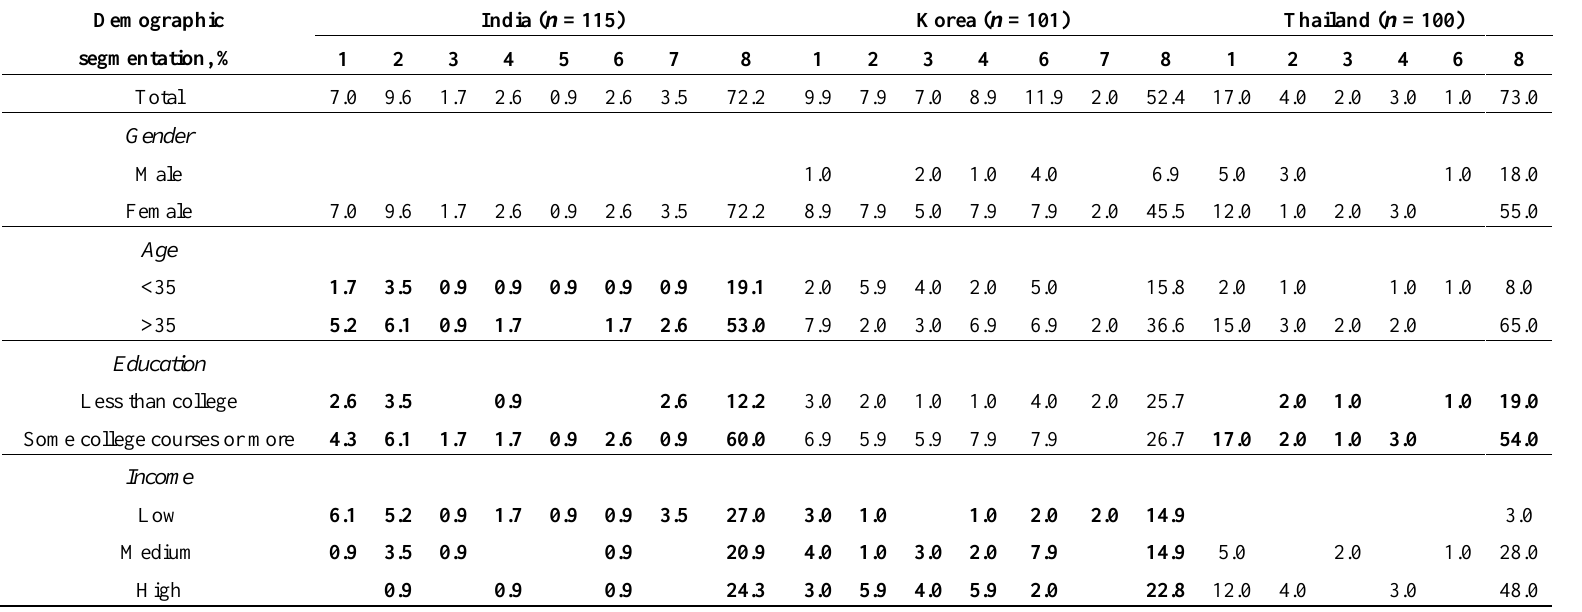
Table 6. Consumers’ raw meat, seafood, and poultry refrigeration and freezing practices. Where would you store the raw meat in the refrigerator? Available options included: Top shelf (1), middle shelf (2), bottom shelf (3), drawer (4), door (5), wherever there is room (6), on the counter or in the cabinet (7), in the freezer